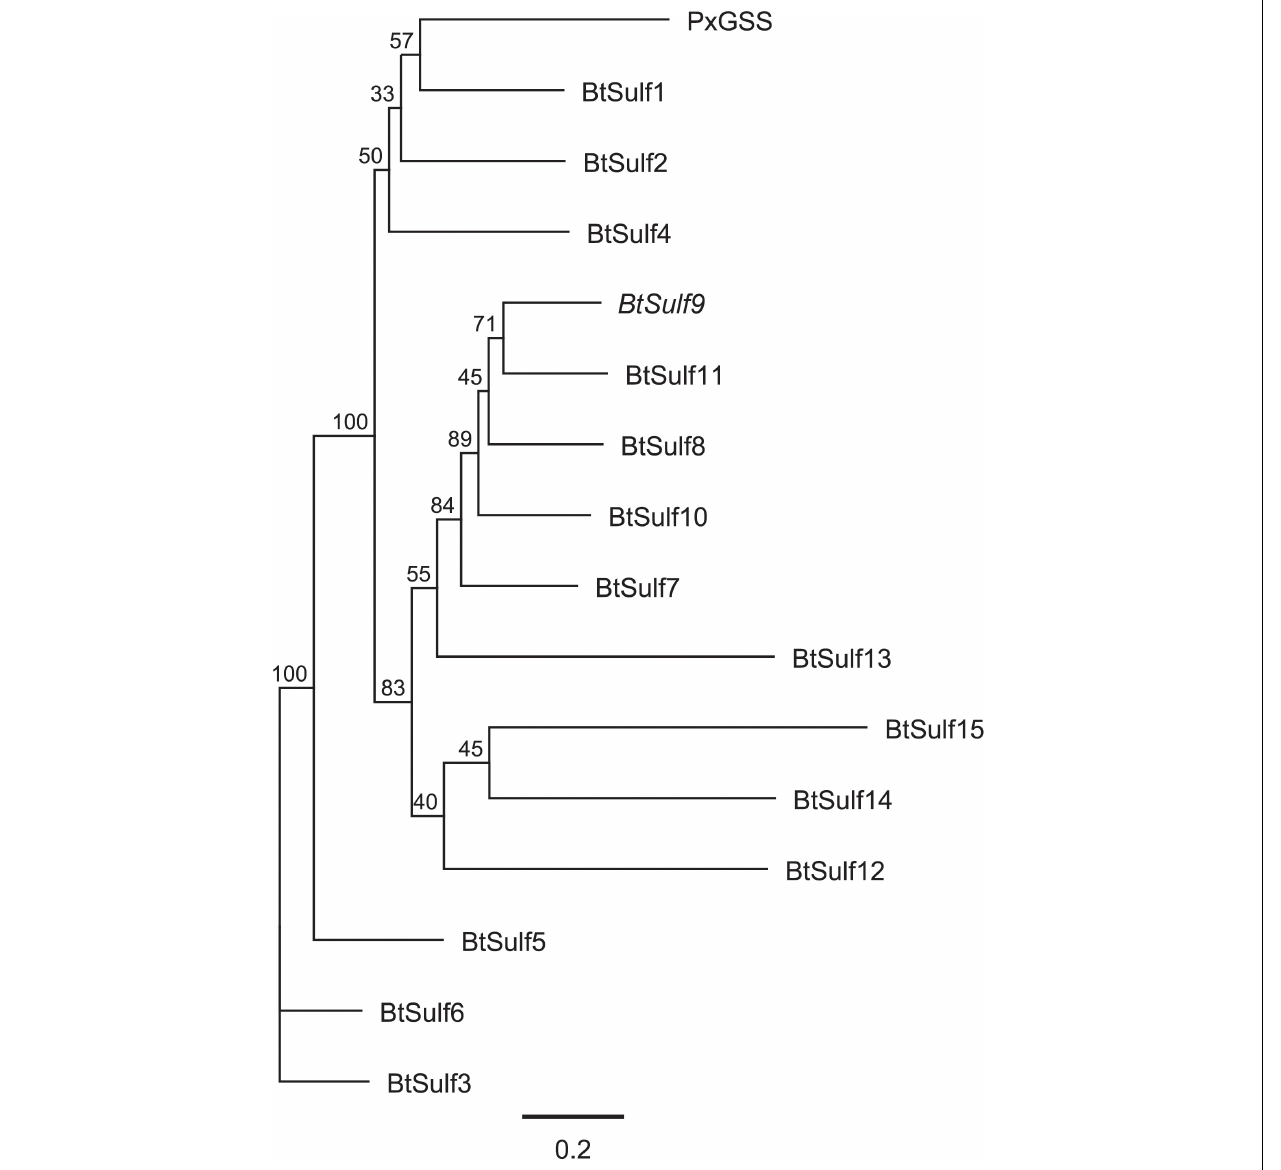
FIGURE 2 | Phylogenetic relationships of predicted Bemisia tabaci sulfatases (BtSulf), including BtSulf9 (BtGSS, italicized) and P. xylostella GSS (PxGSS). Gene names are as described in Table 1 , and bootstrap values (%) are shown next to each